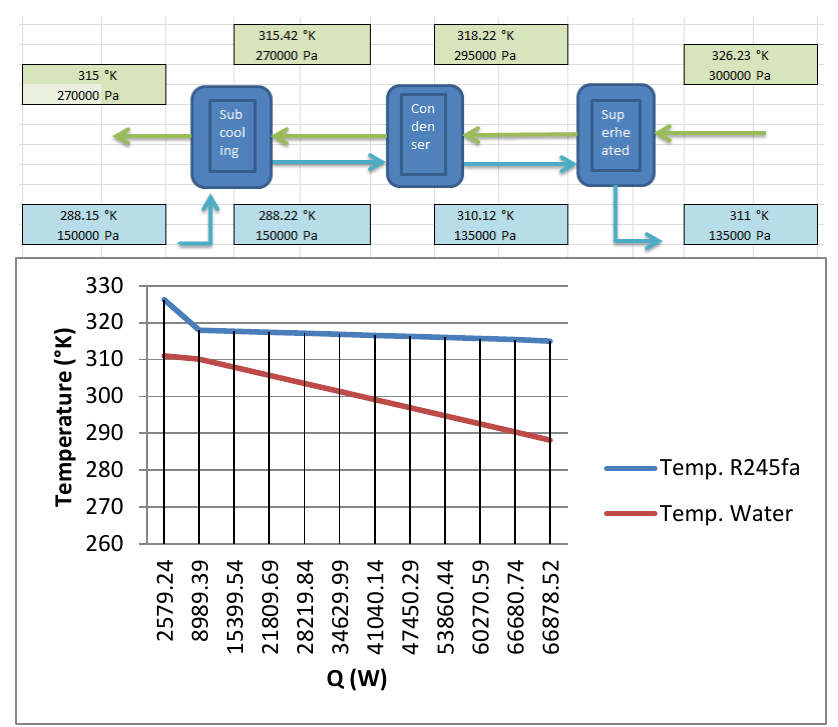
Figure 17. R245fa thermal